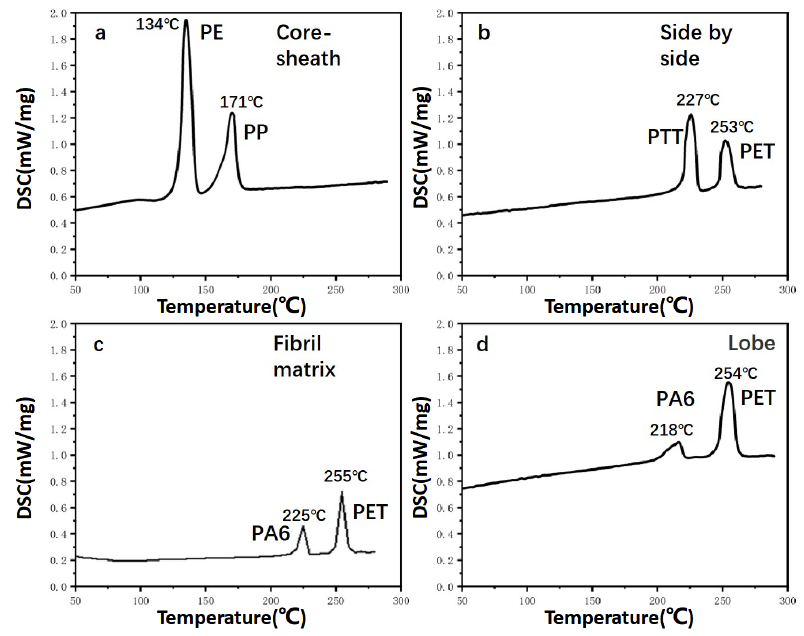
Figure 4. DSC diagram of four kinds of bicomponent fibers: ( a ) core-sheath bicomponent fiber, ( b ) side-by-side bicomponent fiber, ( c ) fibril matrix bicomponent fiber, and ( d ) lobe bicomponent fiber. 3.2. Determination of the Mass Percentage for Each Component by AI Model